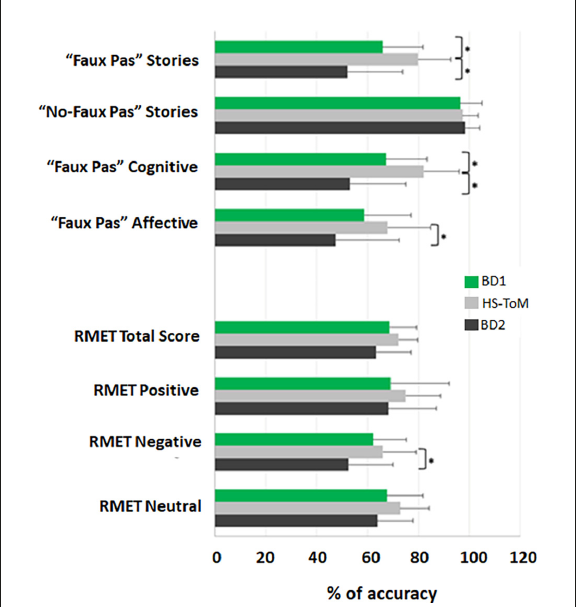
FIGURE1 ToM profile of BD1 and BD2 patients. The results for each test are presented as the percentage of the total number of correct responses(accuracy);0%indicatesnocorrectanswers,and100% indicates totally correct. The mean and standard deviation of the accuracy are reported for BD1, HS-ToM, and BD2. ∗ Statistical